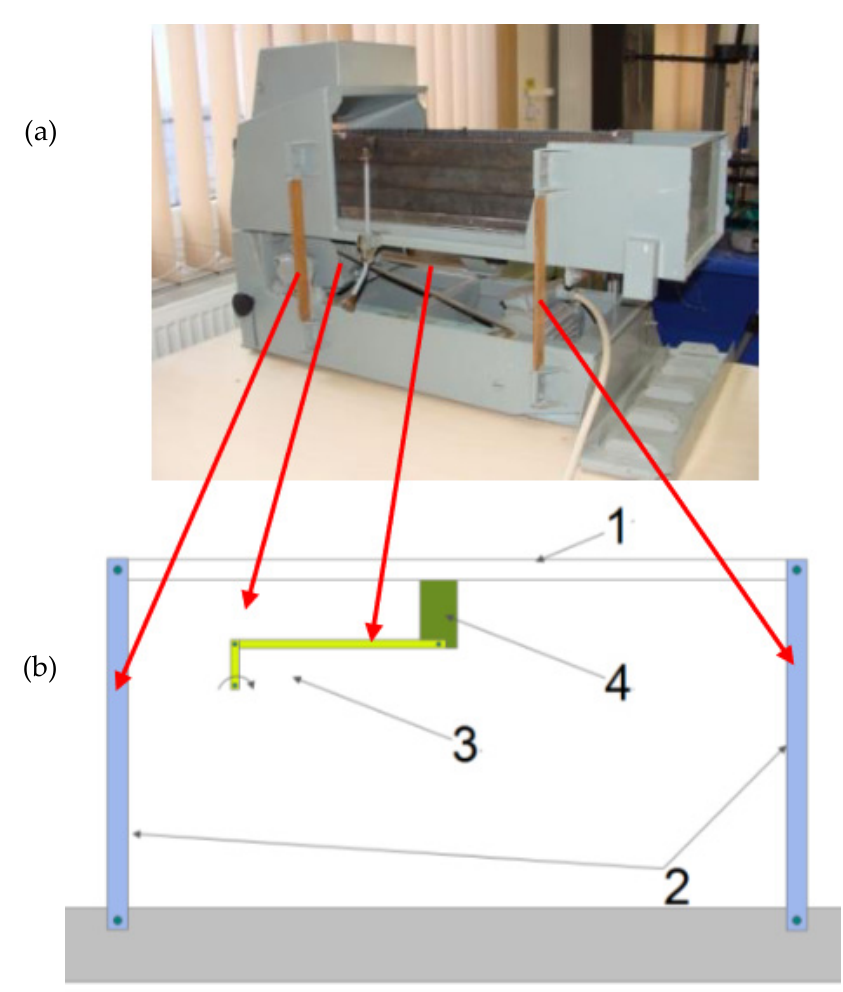
Figure 1. Sieve block drive system [46,47]: ( a ) laboratory equipment; ( b ) schematic representation of the laboratory stand.